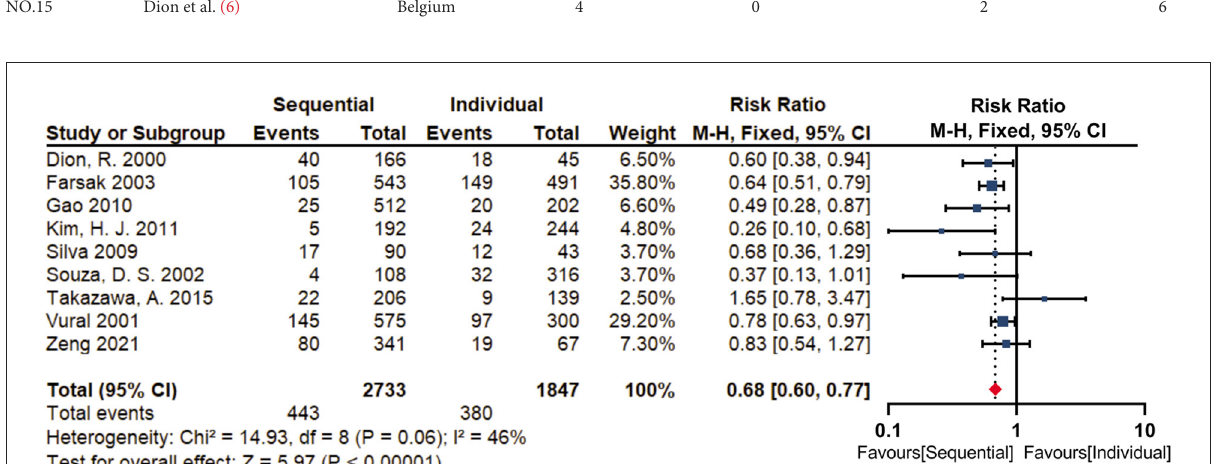
FIGURE3 Forest plot for graft failure. Nine studies reported the failure of the saphenous vein grafts, revealing that sequential group (16.2%) was associated with a significantly lower risk of graft failure (RR = 0.68; 95% CI, 0.60–0.77, P < 0.001) compared with individual group (20.6%).